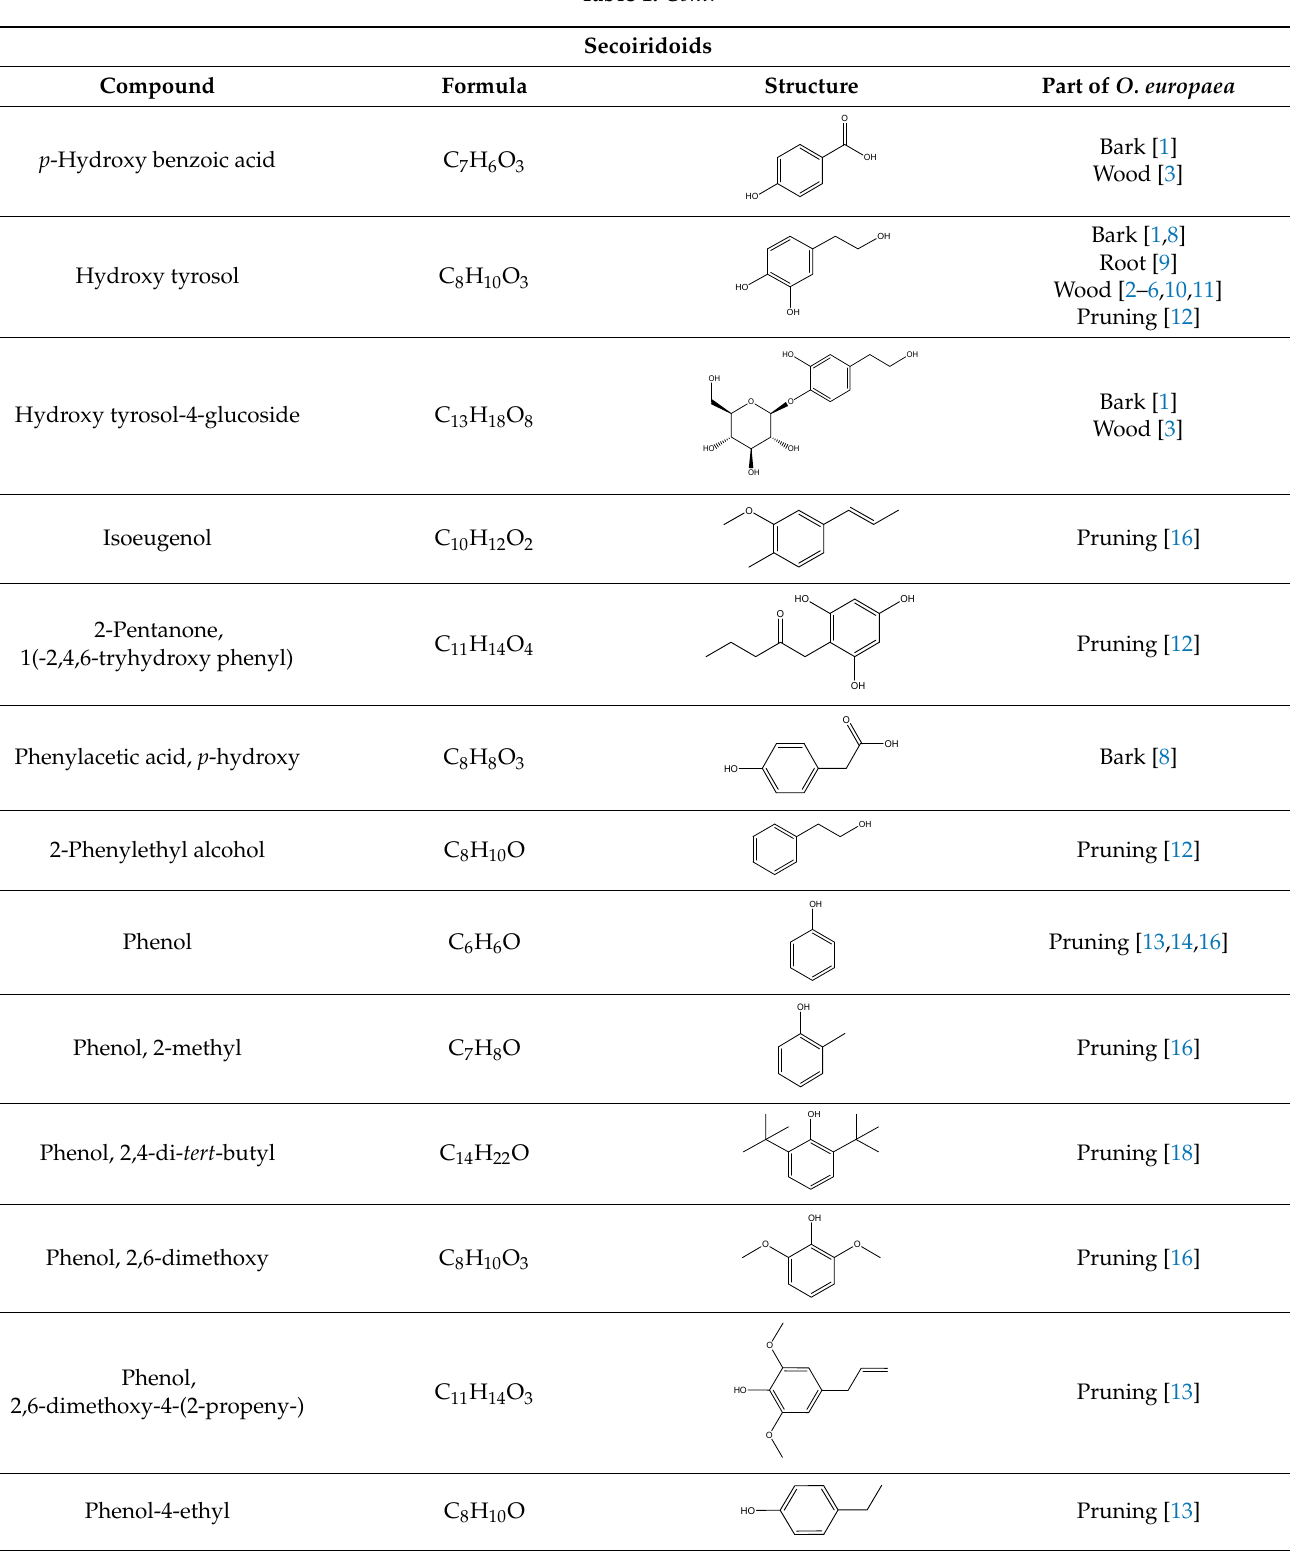
Table 1. Cont. Secoiridoids Formula Structure Part of O.